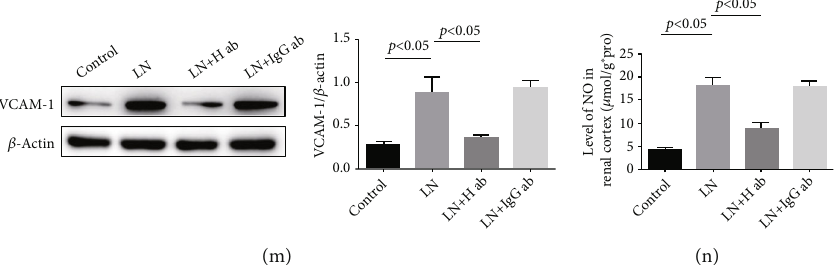
Figure 4: GLY and anti-HMGB1 antibody alleviated the GEC injury in LN. (a – d) TEER and permeability of HRGEC in control, LN, LN +GLY, LN+H ab, and LN+IgG ab groups ( n = 5 ). (e, f) SDC-1 (green) in HRGECs was detected by IF staining. (g, h) The level of SDC-1 in supernatant was measured by ELISA ( n = 5 ). (i, j) Colocalization of VE-cadherin (green) and F-actin (red) in HRGECs was detected by IF staining. (k, m) The expression of VCAM-1 in HRGECs was measured by western blotting. (l, n) The level of NO in HRGECs ( n = 5 ). GLY: glycyrrhizin; H ab: anti-HMGB1 antibody; IgG ab: control IgG.